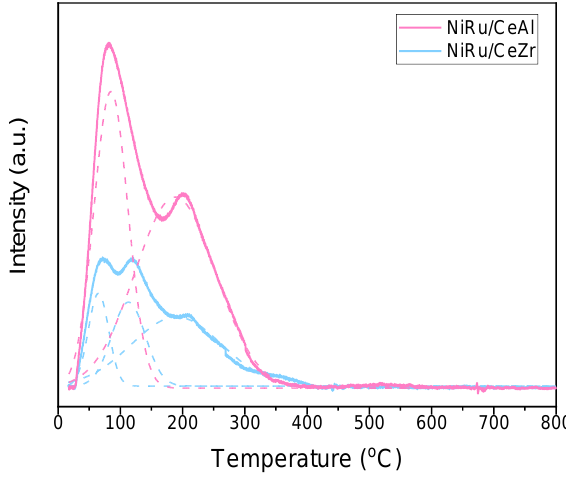
Figure 3. CO 2 -TPD profiles of NiRu/CeAl and NiRu/CeZr. Table 2. Summary of characterisation data of NiRu/CeAl, NiRu/CeZr [26], and NiRuK/CeAl [51].